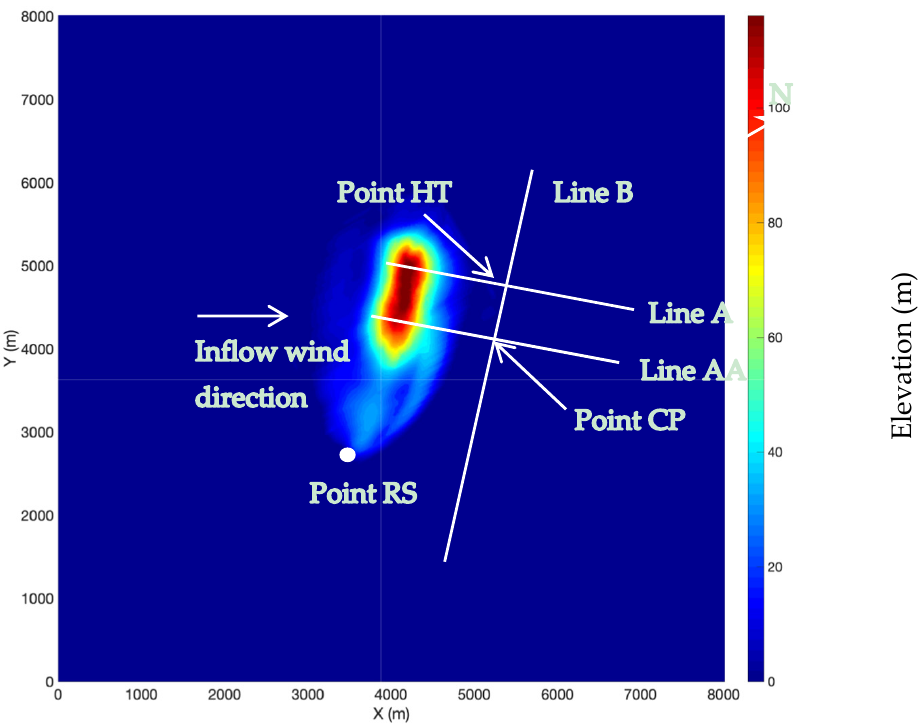
the vertical extent of 1 km. A uniform Cartesian mesh was created using a grid resolution of ∆ x , ∆ y = 20 m, and ∆ z = 10 m resulting in~16 million grid cells. The inflow velocity profile was created using a log-law profile ( u = ( u ∗ / k ) ln( z / z 0 )), to fit the observed data from the upstream site RS as shown in Figure 3. The value of surface roughness, z 0 , was 0.03 m [14] and the friction velocity u ∗ was derived using the velocity reading ( u r = 14 m/s at z r = 60 m) at the reference site